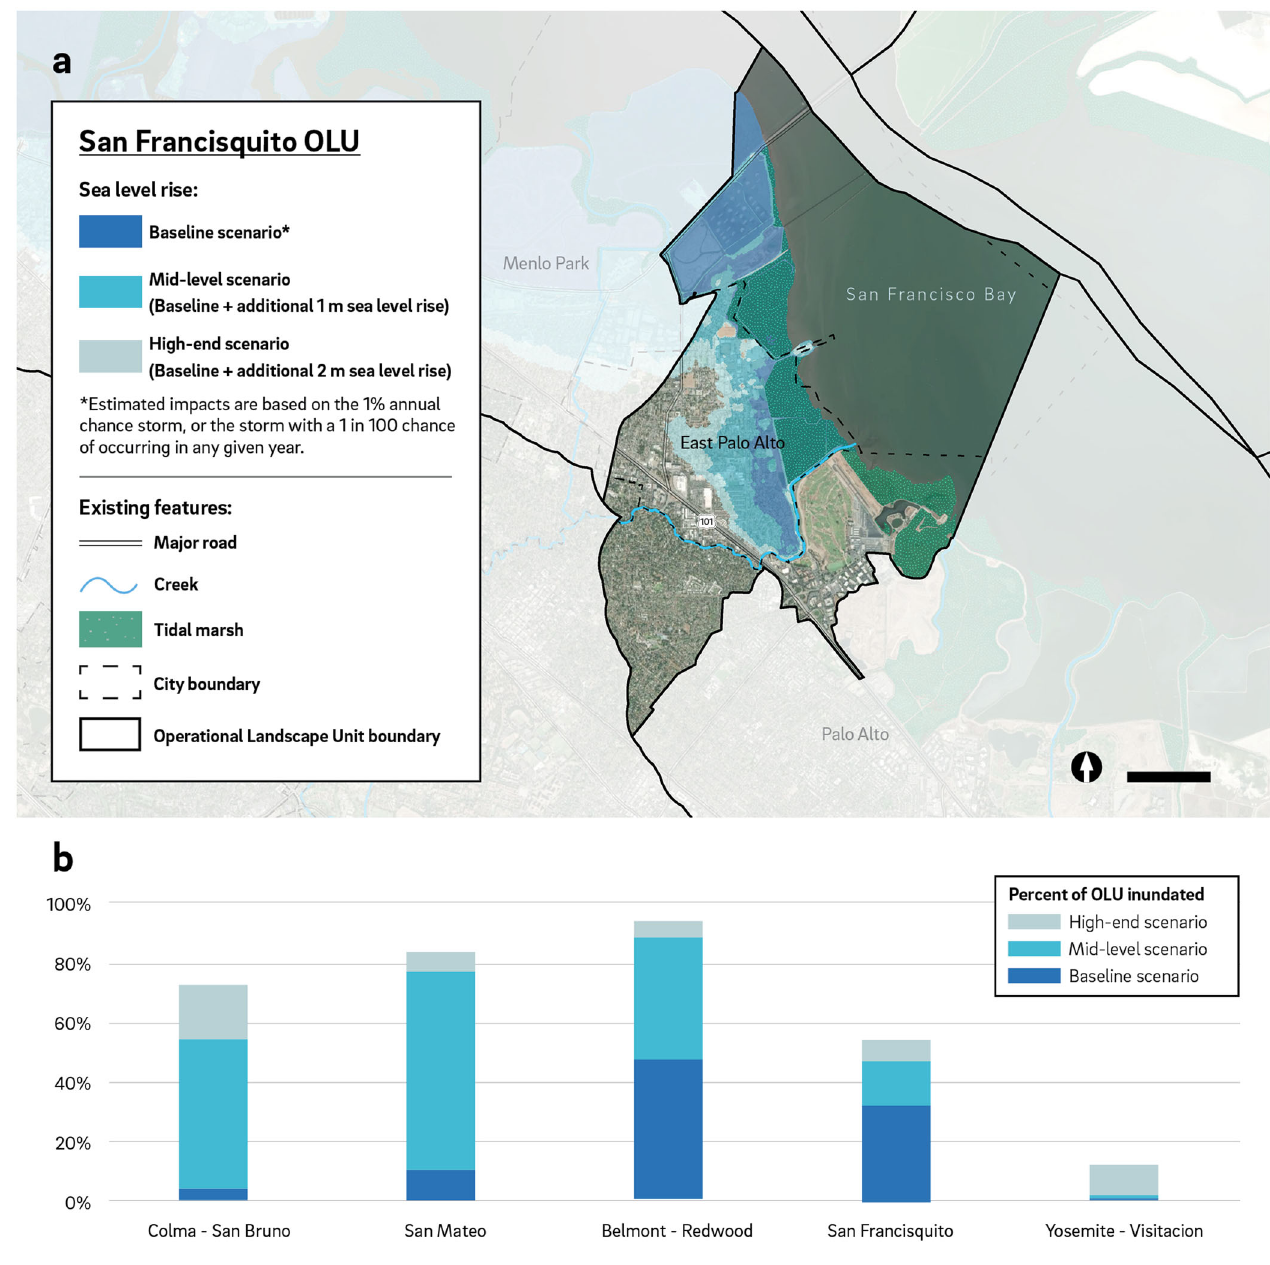
Fig. 2 Sea-level rise exposure. a Exposure in the San Francisquito Operational Landscape Unit (OLU) and b exposure throughout the County ’ s 5 OLUs. San Francisquito is the southernmost OLU in San Mateo County. Darker blues represent expected fl ooding in the baseline scenario and lighter blues represent fl ooding in the mid-level and high-end scenarios. Black scale bar in panel ( a ) represents 1